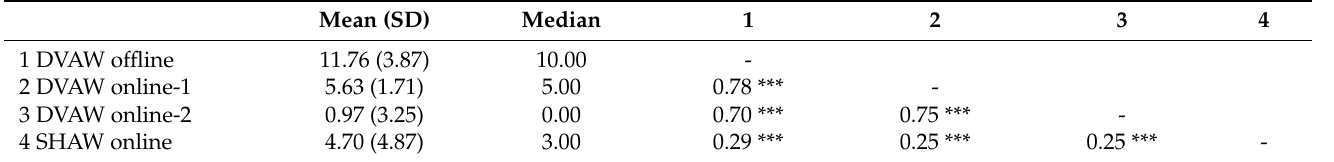
Table 1. Descriptive statistics and correlations between variables used for the formation of clusters and descriptive statistics.